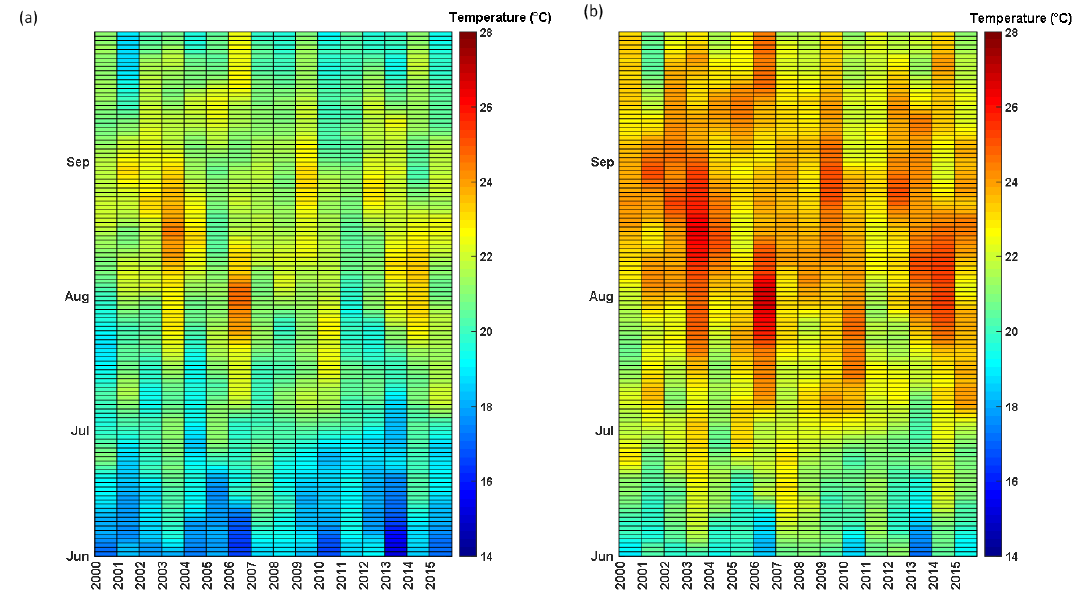
Figure 5. Simulations of T soil at − 1.0m in the average city (a) and in the hotspots (b) from 2000 until 2015 during the months June, July, August and September.